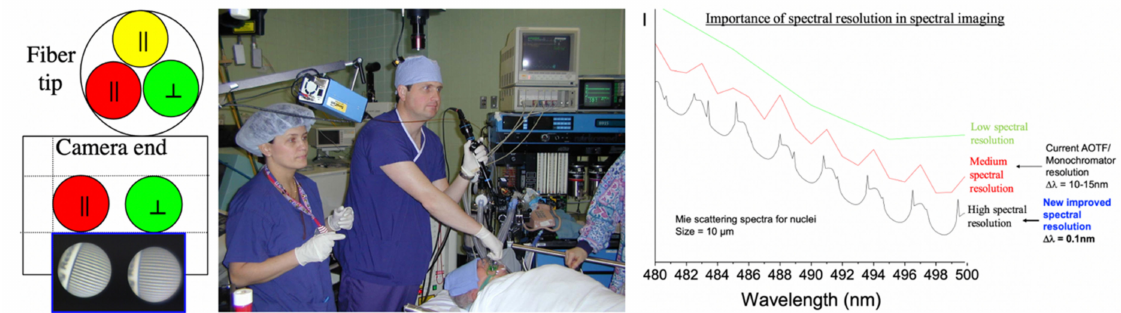
Figure 24. Elastic scattering imaging endoscopy. (Left) : custom fiber distributions and polarizations; ( Middle ): The workstation during an endoscopic procedure at AGH, Pittsburgh; ( Right ): Improvement in spectral resolution shows true Mie scattering oscillation